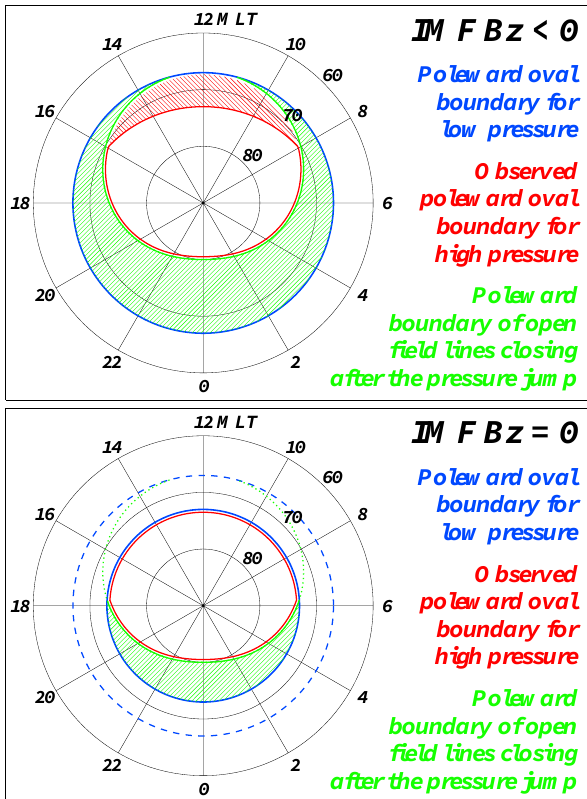
Fig. 8. A diagram illustrating the role of enhanced magnetotail re- connection in closing the polar cap after the arrival of the pressure front, for IMF B z < 0 (top) and IMF B z ≈ 0 (bottom). The green hatched area in both panels represents the area of previously open tail field lines now closing due to the pressure enhancement. This mechanism, however, cannot account for the dayside polar cap clos- ing when IMF B z < 0 (red hatched area on the top panel).